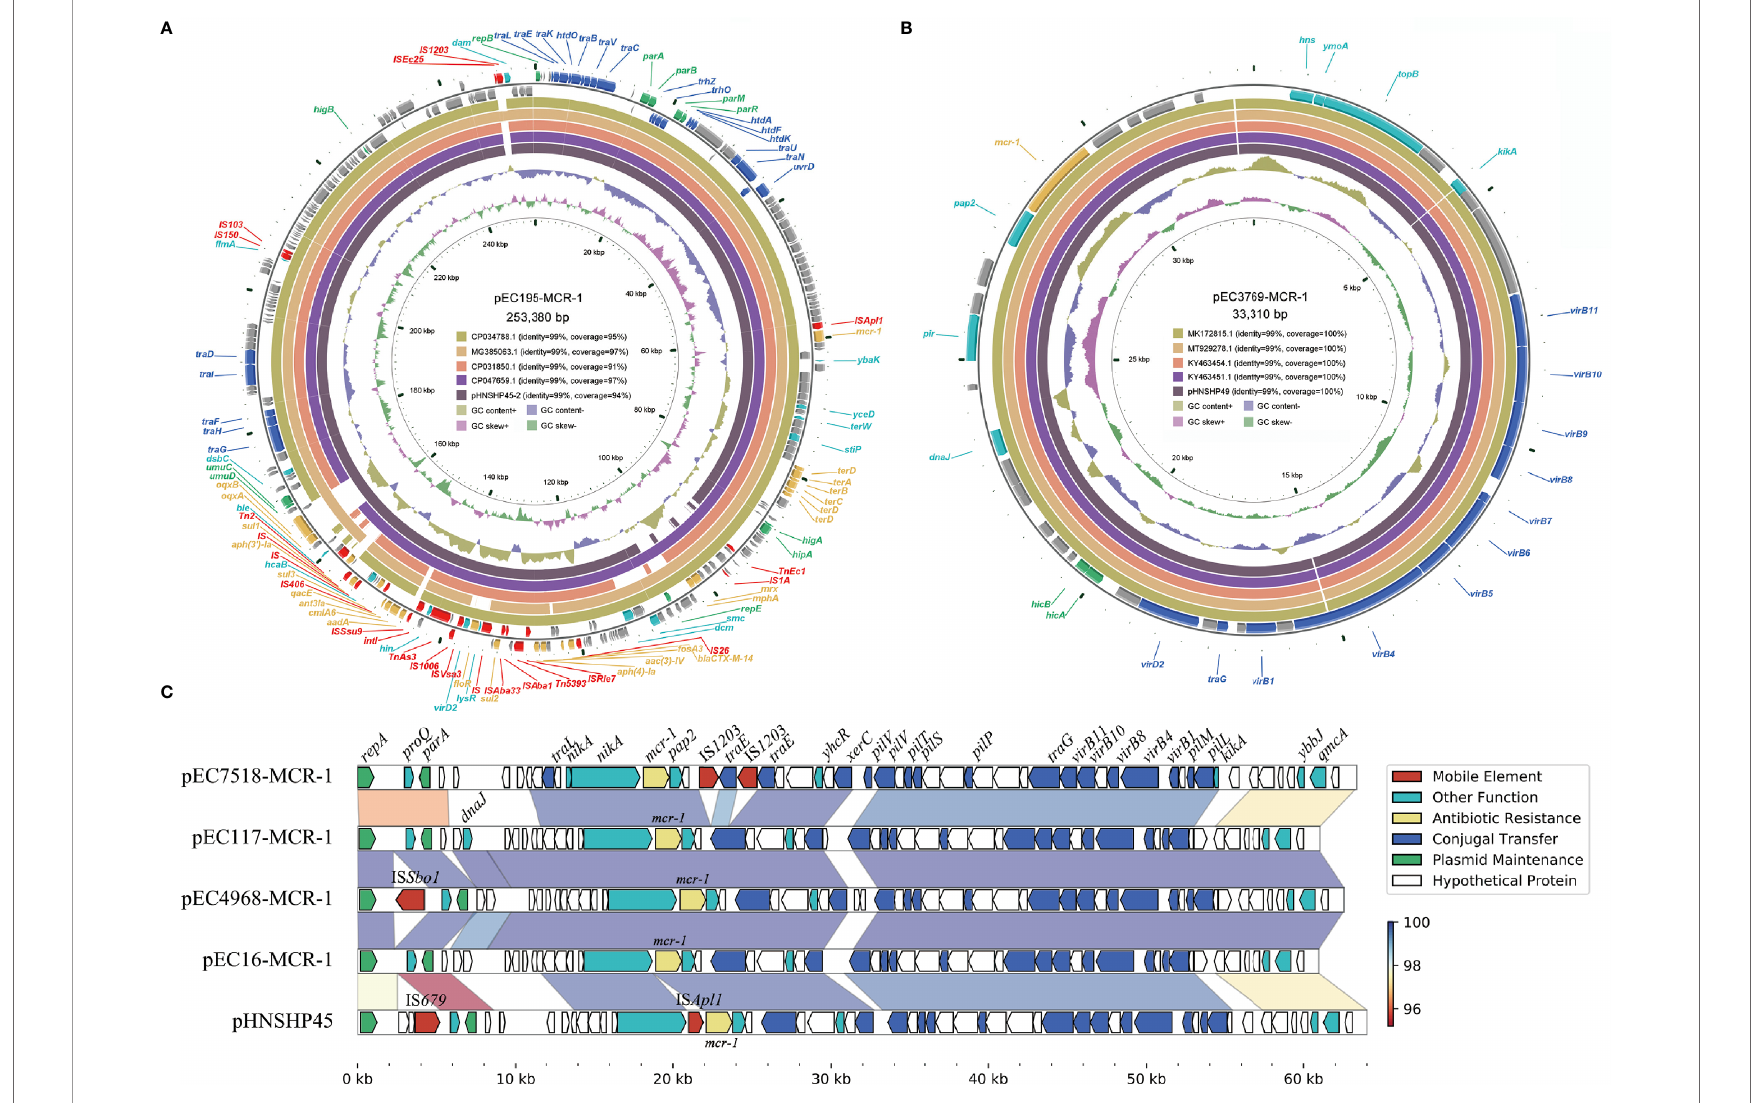
FIGURE 3 | Diagram of the six mcr-1 -harboring plasmids. (A) the plasmid map of pEC195-MCR-1; (B) the plasmid map of pEC3769-MCR-1; (C) Comparison of the four IncI2 plasmids and pHNSHP45. Genes are denoted by arrows and are colored based on gene function classi fi cation. Regions of > 95% identity are marked by gradient